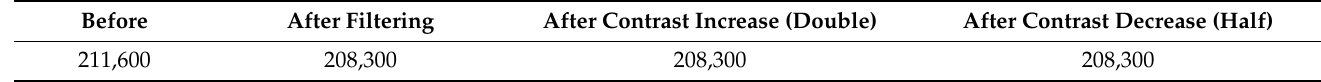
Table 4. Distribution of all fire images in the dataset.